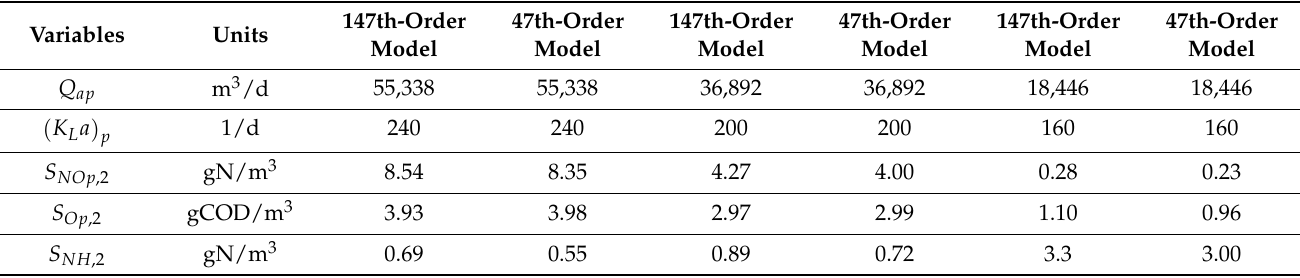
Table A1. Steady-state values of variables of interest of the 147th-order and 47th-order models at three different set of